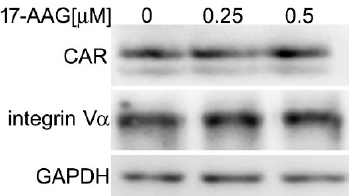
Figure 3. Level of receptors for HAdV-5 is not affected by Hsp90 inhibition. A549 cells were cultured for 24 h in the indicated concentrations of 17-AAG. 10 μ g of a total protein extract was loaded on a gel and probed with antibodies specific for CAR and integrin α V. The experiment was repeated twice with identical results.